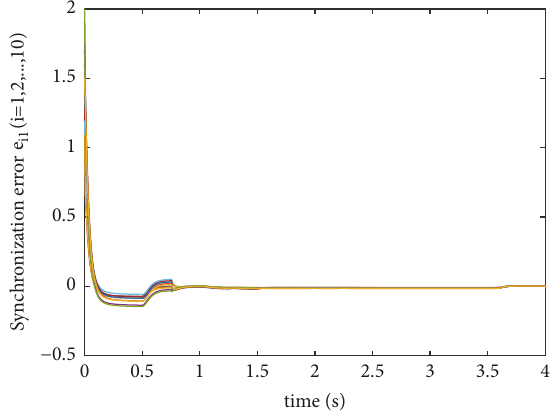
Figure 1: The synchronization error 𝑒 𝑖1 (𝑖 = 1, 2, . .. ,10) state.